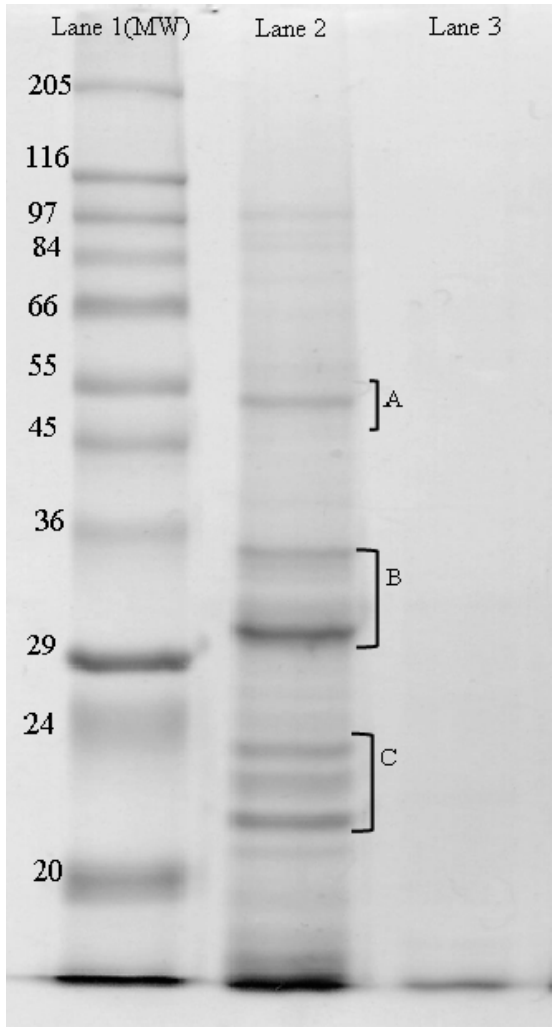
Figure 2 . SDS-PAGE characterization of quinoa proteins soluble at pH 9 (lane 2) and pH 4 (lane 3). MW: molecular weight marker; A: 7S globulin 45 kDa; B: globulin acid subunit; C: globulin basic